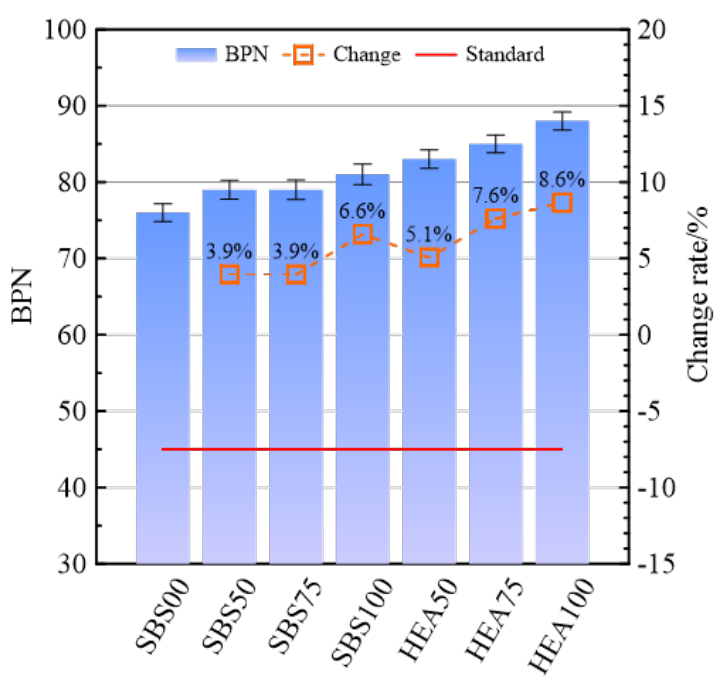
Figure 6. Anti-skid index of Figure 2. The agent interacts with the environment. When the agent observes the environment’s state, the agent chooses action from the list of action pulled by maximum Q-value requirement which is the target of RL algorithms. And then, agent get the reward which depends on the action execution. Environment’s state changes to new state, the next step starts.